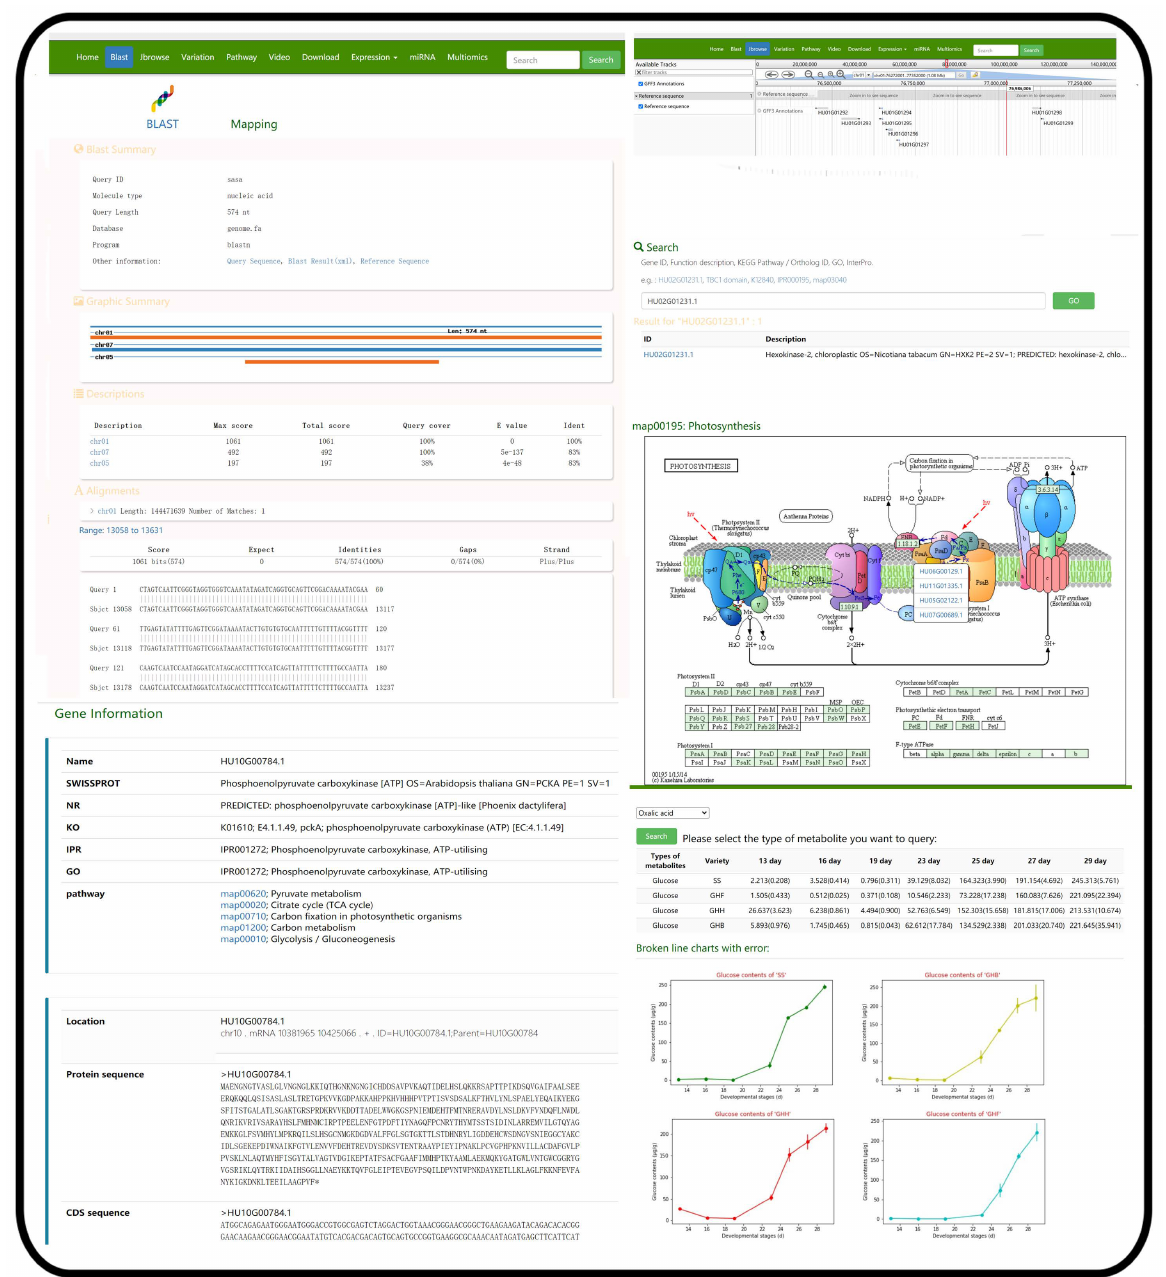
Figure 3. The screenshots of representative resources and action page examples for the ‘Blast’, ‘Gene Browse’ and ‘Search’ modules. The ‘Blast’, ‘Gene Browse’ and ‘Search’ modules showing detailed information of genes identified in this study including gene loci and sequence position of the gene in KEGG pathway. The trends of various metabolite data during pitaya fruit development were presented by line chart and